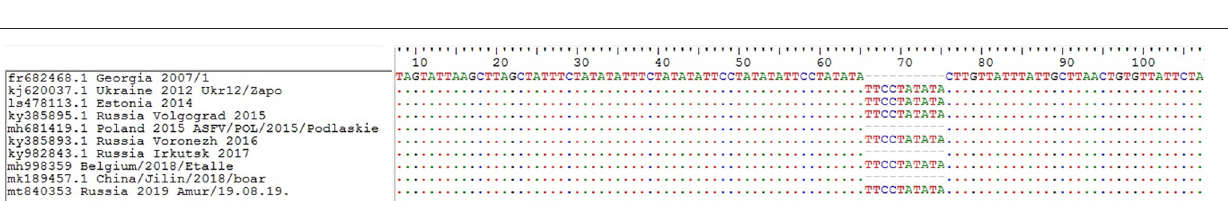
outbreaks both in WB and DP, which are widely spread across its